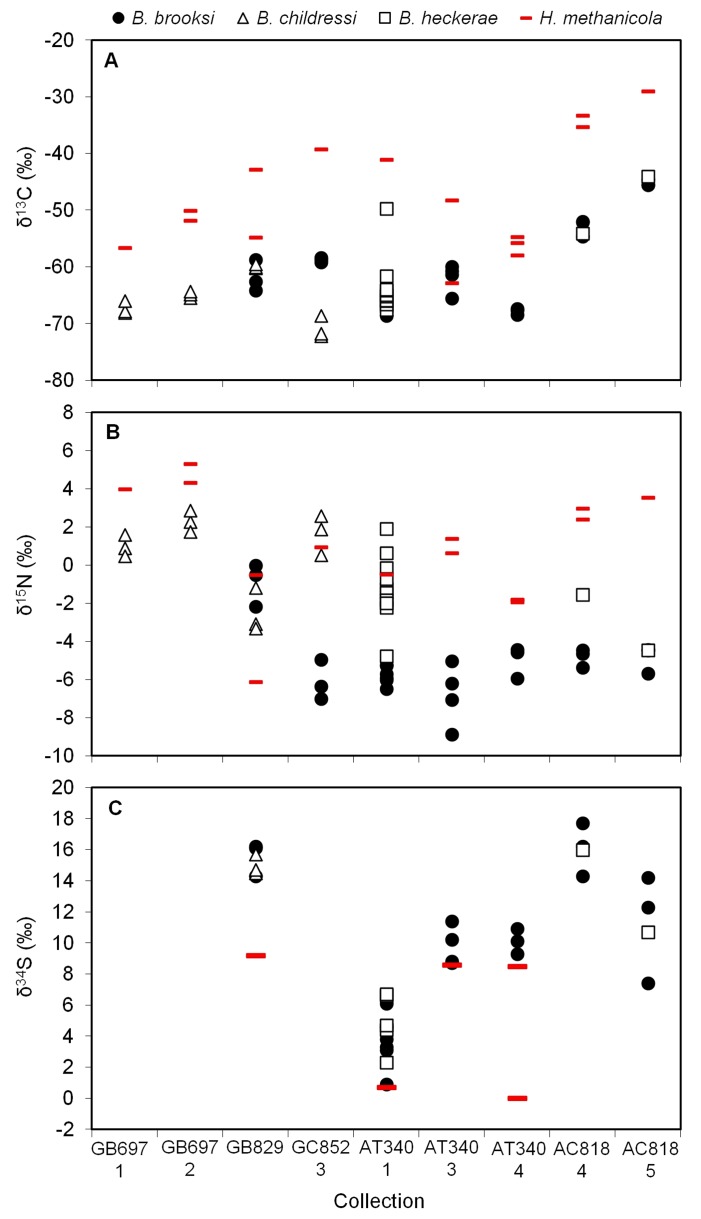
Tissue stable isotope values for the methane ice worm

Hesiocaecamenthanicola

 and Bathymodiolus mussels separated by collection.(A) δ13C vs. collection, (B) δ15N vs. collection, and (C) δ34S vs. collection. Different symbols are used for different Bathymodiolus species.